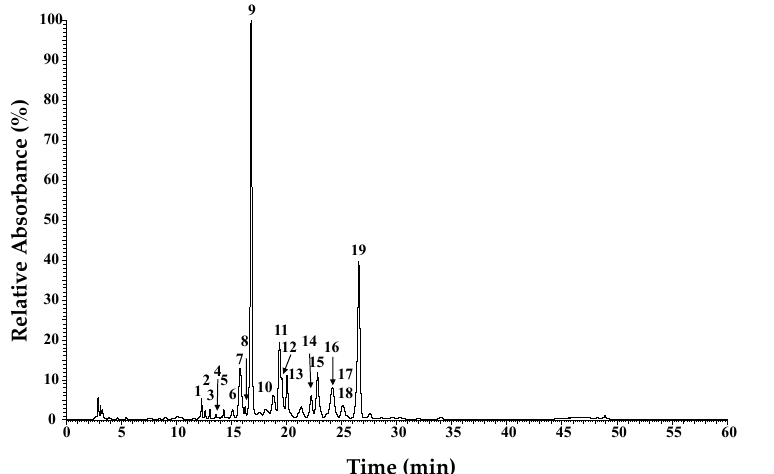
Figure 1. Chromatographic profile of Castanea pollen samples obtained at 280 nm using LC/DAD/ESI-MS n .